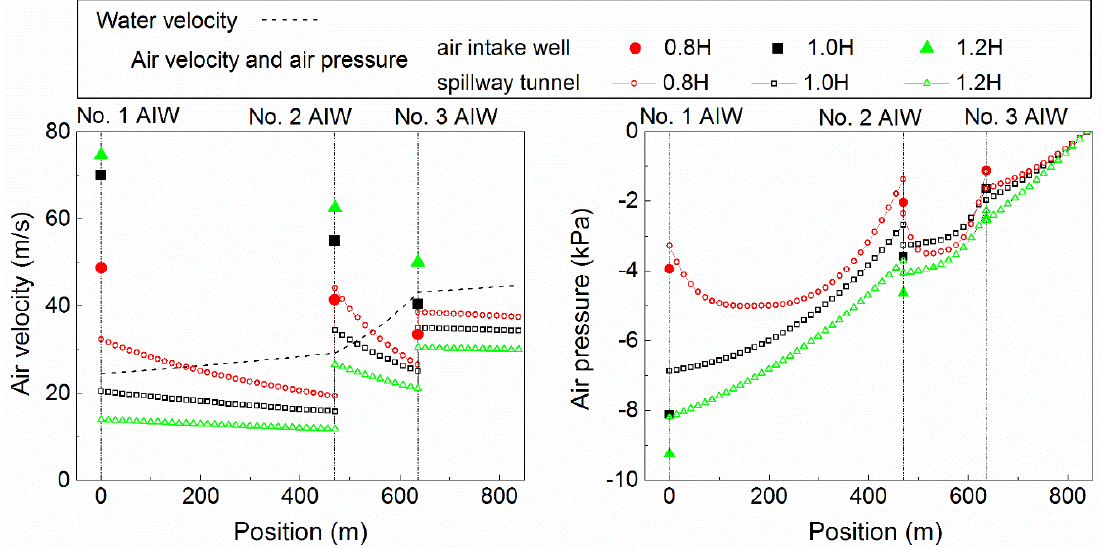
Figure 9. Influence of the cross-sectional height of the spillway tunnel on the ventilation characteristics.